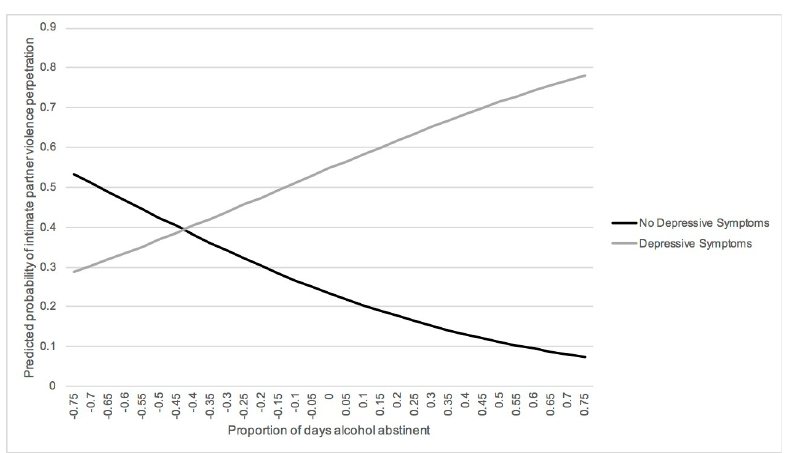
Fig 2. Estimated intimate partner violence perpetration as a function of depressive symptoms and proportion of days alcohol abstinent at times when participants screened positive and negative for depressive symptoms. On the X-axis, the zero value is each participant’s average proportion of days alcohol abstinent reported across the study period. Values greater than zero represent participants reporting higher proportion of days alcohol abstinent than average and values less than zero represent participants reporting lower proportion of days alcohol abstinent than